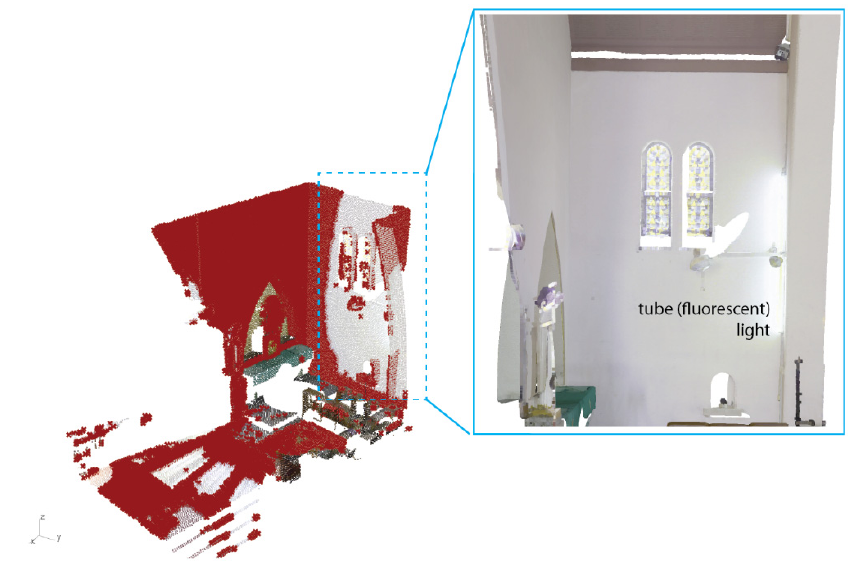
Figure 7. An enlarged spot of A/(a) dataset.